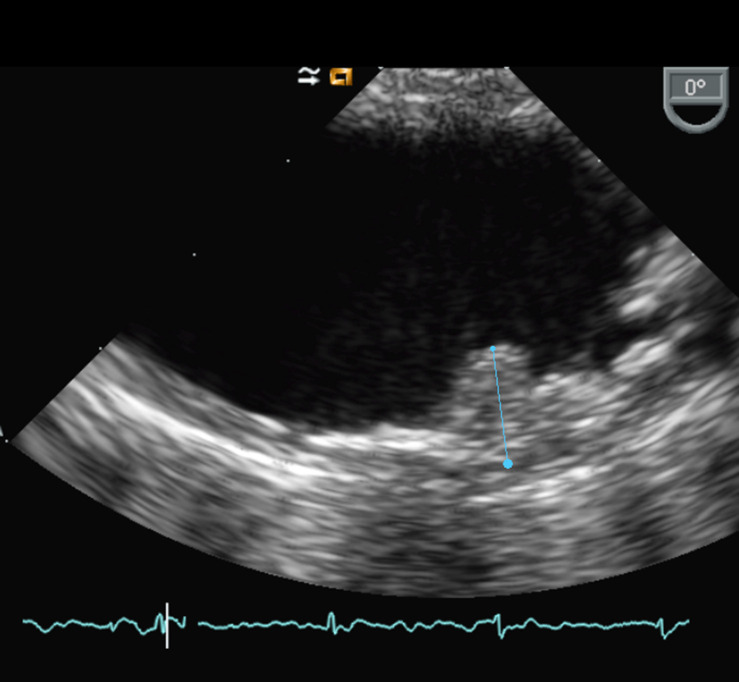
Transesophageal echography of the aortic arch showing protruding AAA.